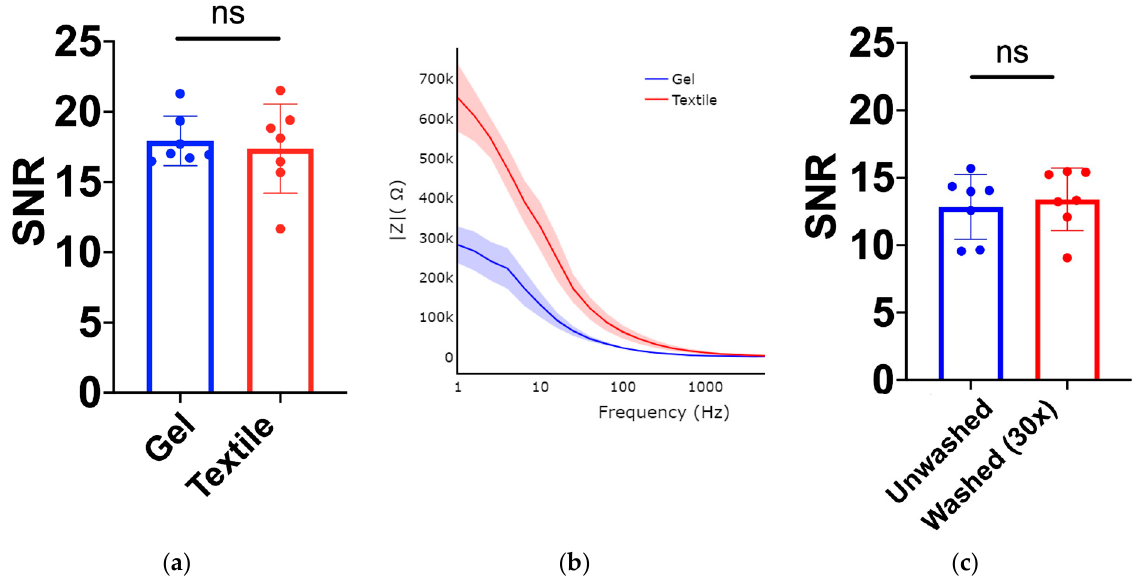
Figure 7. SNR calculations on EMG signal collected on Ch. 2 of EMG textile sleeve (Figure 2c channel locations) during all finger flexion hand pose. ‘ns’ represents ‘not a statistically significant difference’ between the groups. Bar graphs represent the standard deviation of the mean. ( a ) Gel Electrode (2 cm diameter) vs. textile electrode swatch (2 cm × 2 cm), ( b ) Skin-electrode Impedance plot for unwashed textile electrode (2 cm × 2 cm) and gel electrode (2 cm diameter), ( c ) Unwashed textile electrode swatch (2 cm × 2 cm) vs. Washed textile electrode swatch (2 cm × 2 cm).